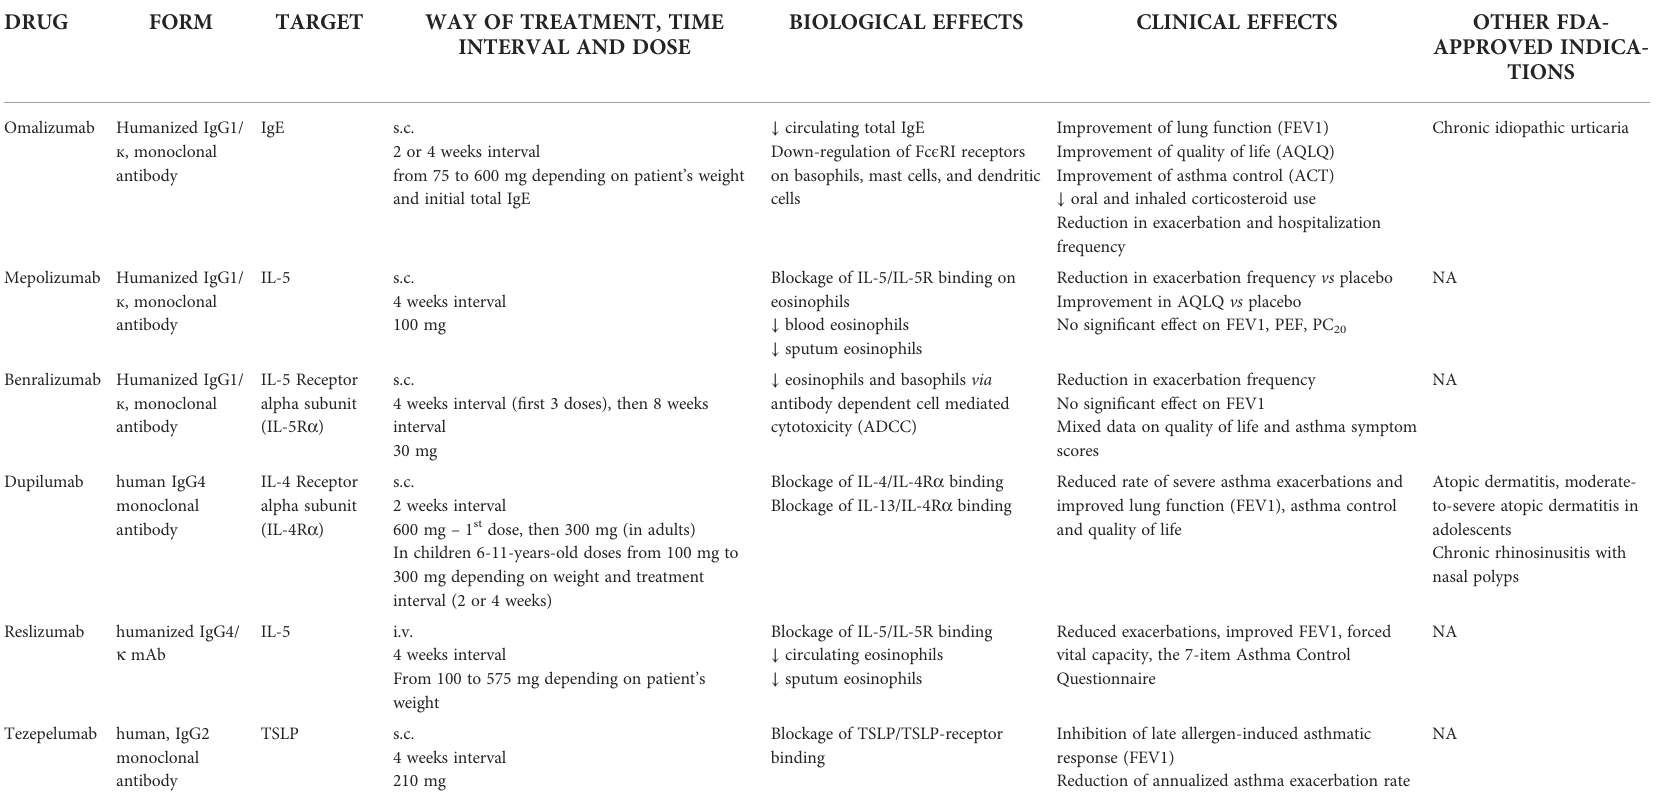
TABLE 1 Current clinical options with monoclonal antibodies in severe